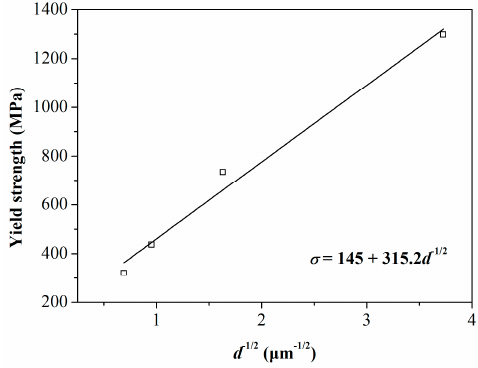
Figure 8. Yield strength vs. the inverse square root of grain size.